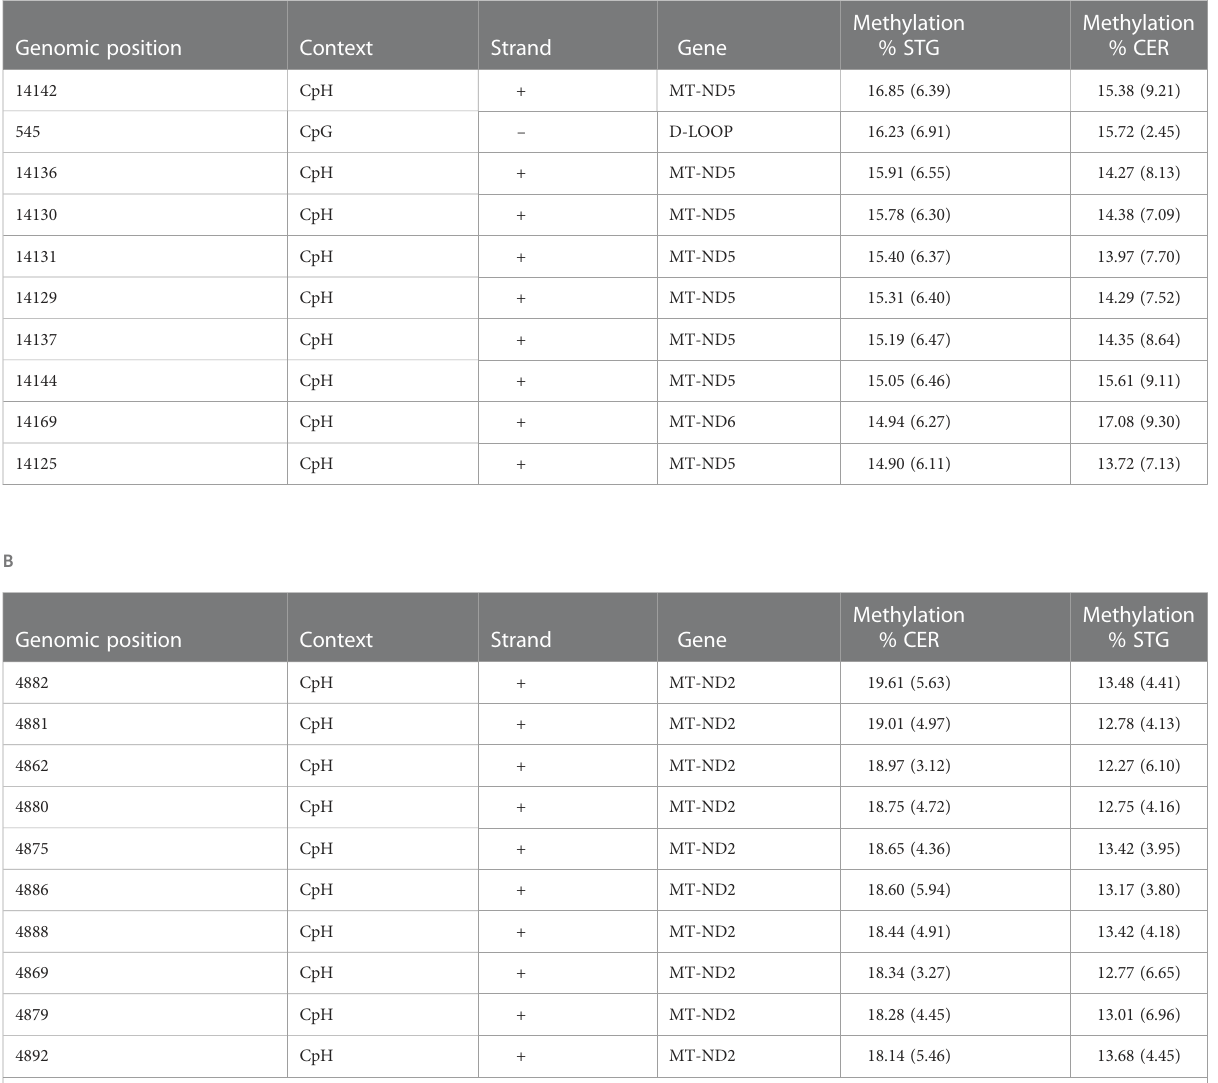
TABLE 1 The 10 most highly methylated sites in